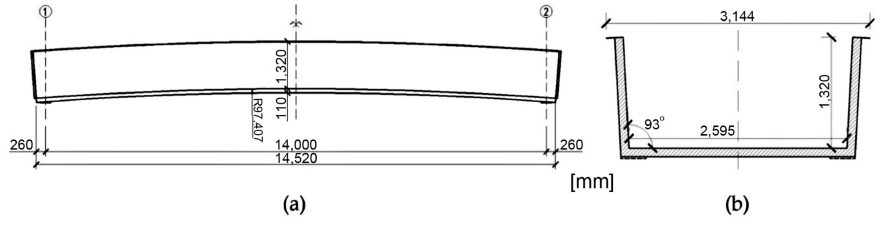
Figure 2. Footbridge views: ( a ) Side view; ( b ) Cross section.